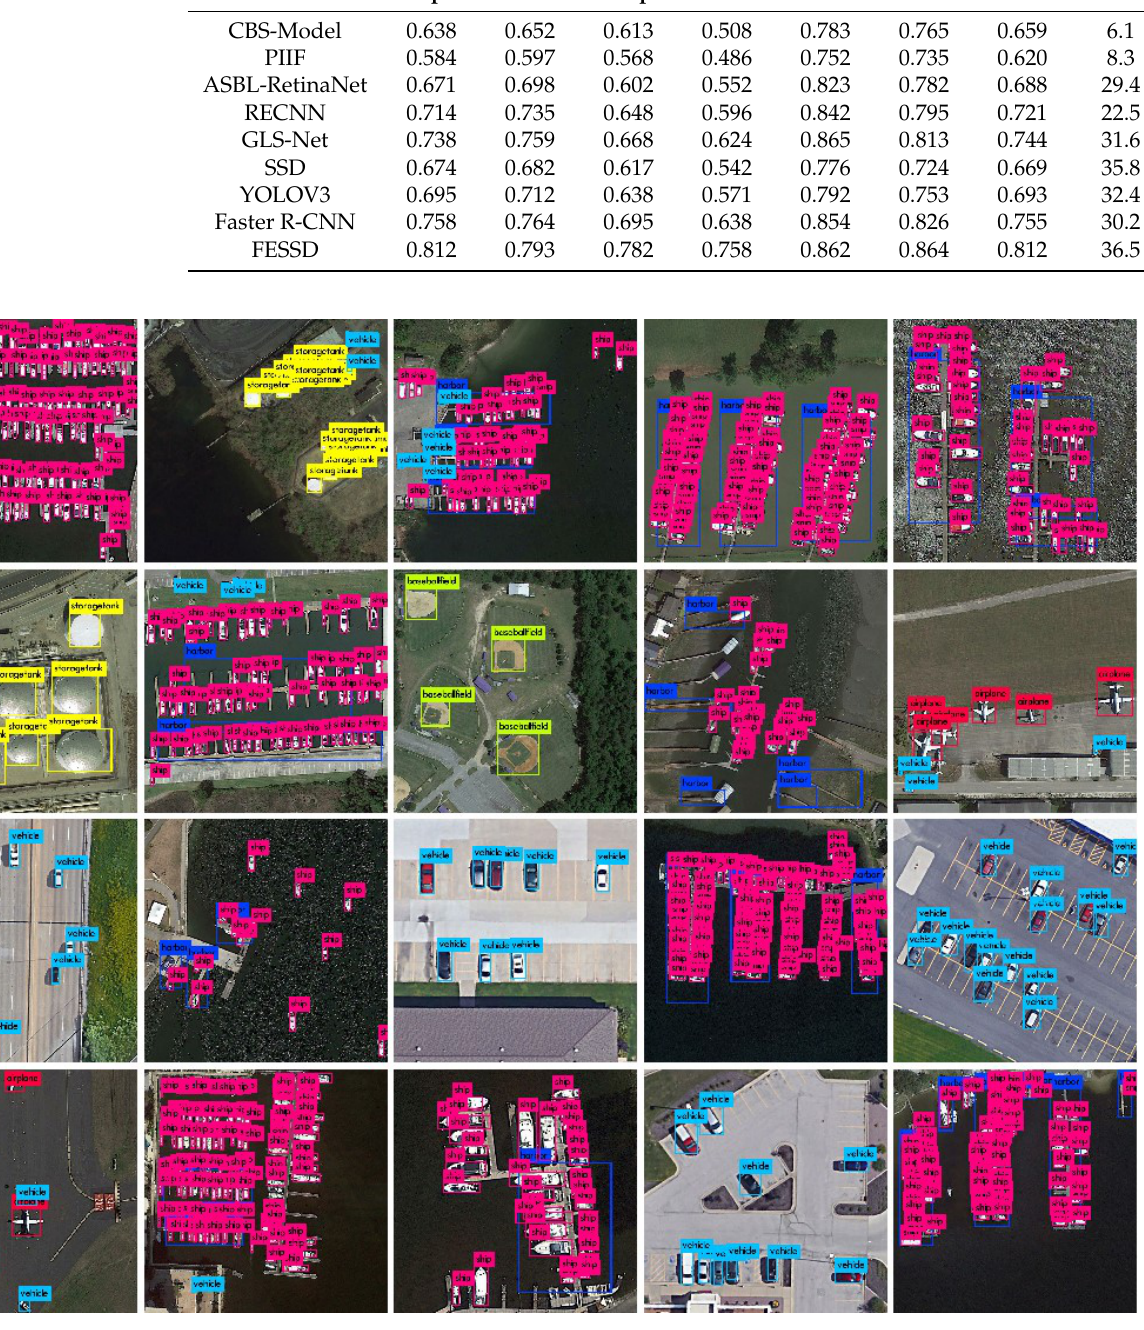
Figure 8. Visual detection results of FESSD on the DIOR